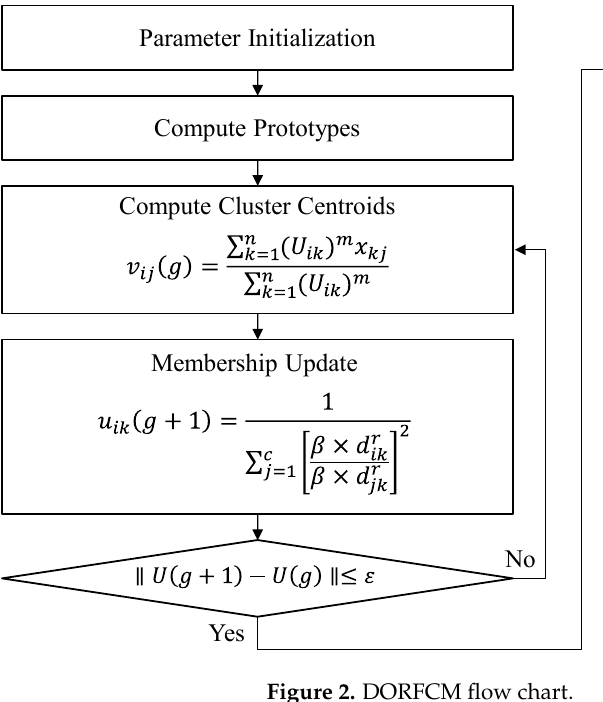
Figure 2. DORFCM flow chart.